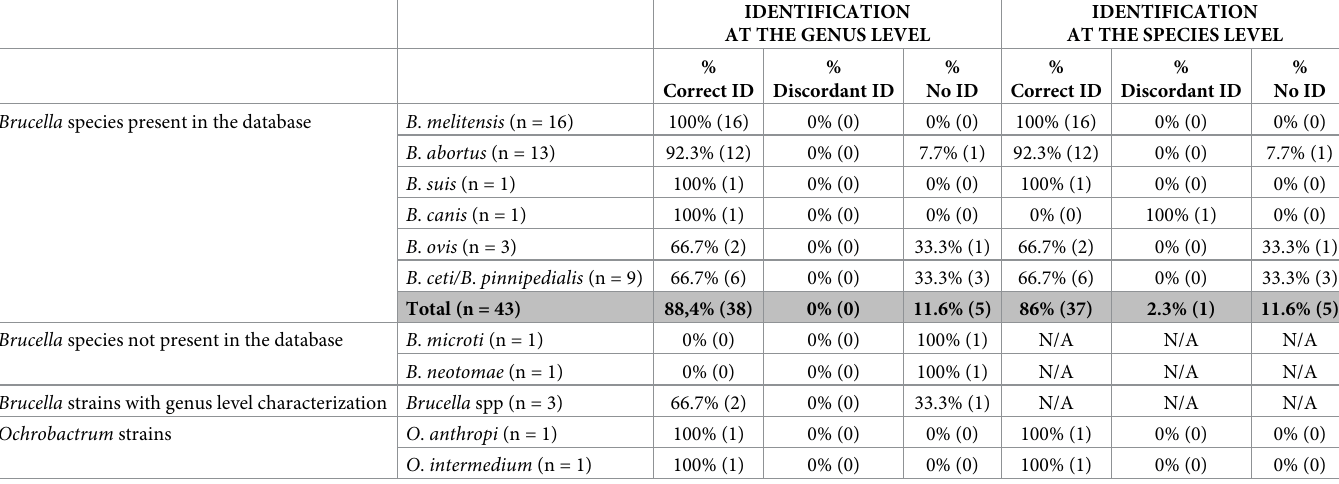
Table 4. Identification results in external validation. Identification (ID) results, either at genus or species/class level, were classified as correct, discordant or no-identifi- cation (No ID). This table gives the % of strains for which each type of identification result was obtained using the updated database. The number (n) of strains tested for each species/class is also indicated in parenthesis. N/A = not